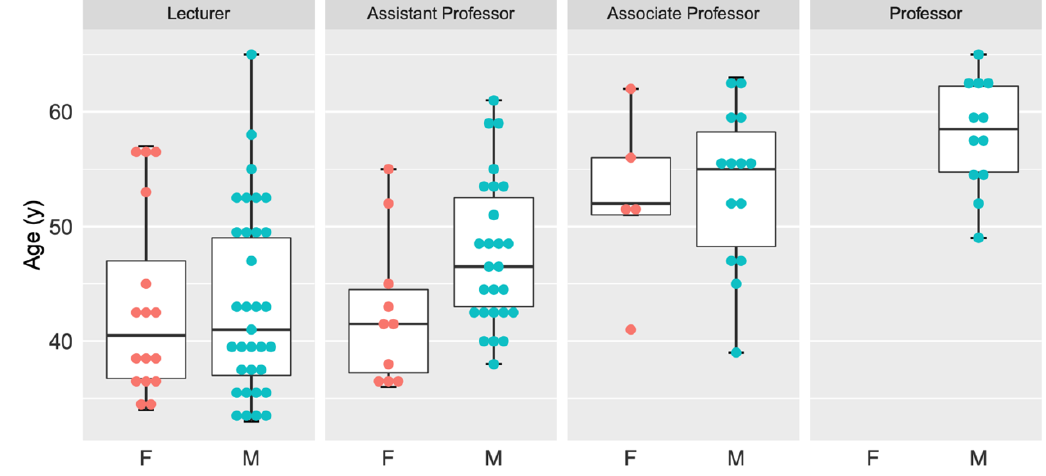
Figure 2. The age and gender distribution of family medicine academic faculty by rank.